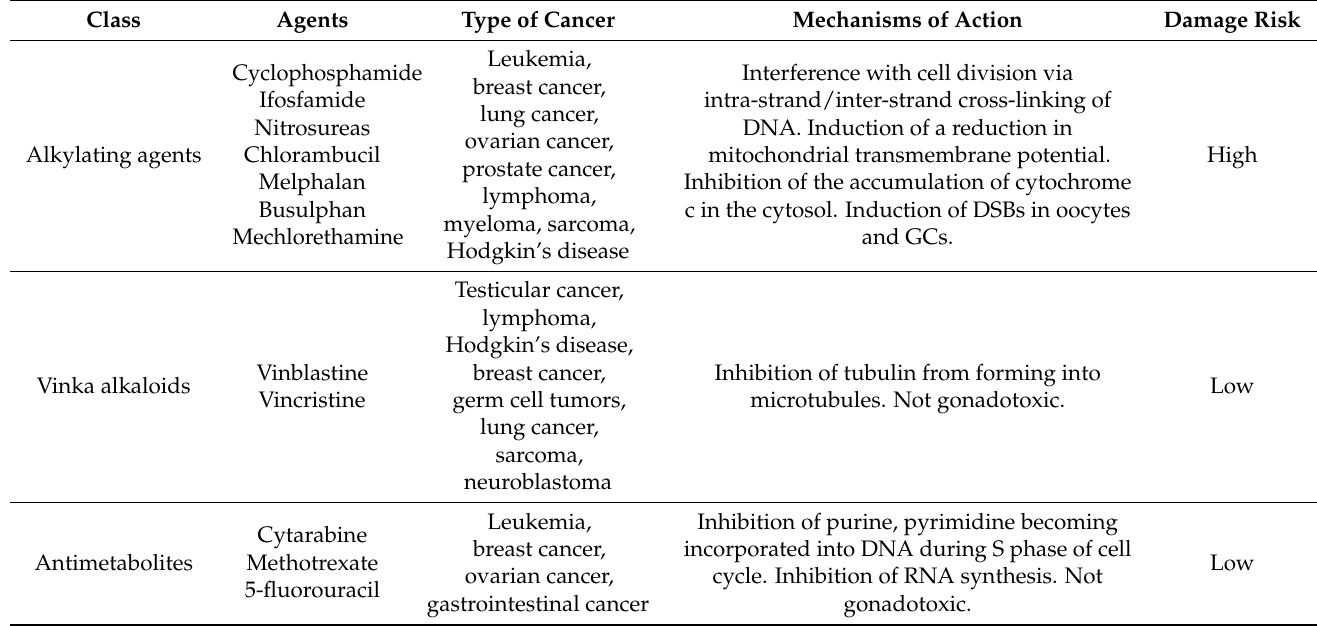
Table 1. Ovarian damage risk with chemotherapeutic agents and their respective mechanisms of action.